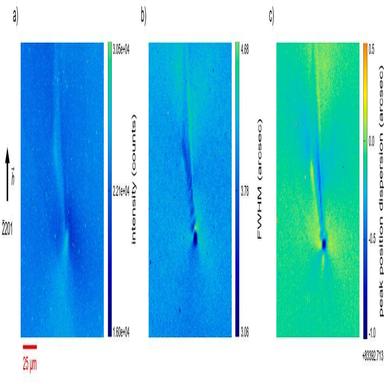
Dislocation in GaN (2201 reflection, 30 keV), a) Integrated intensity map, b) FWHM map, c) Peak position map.